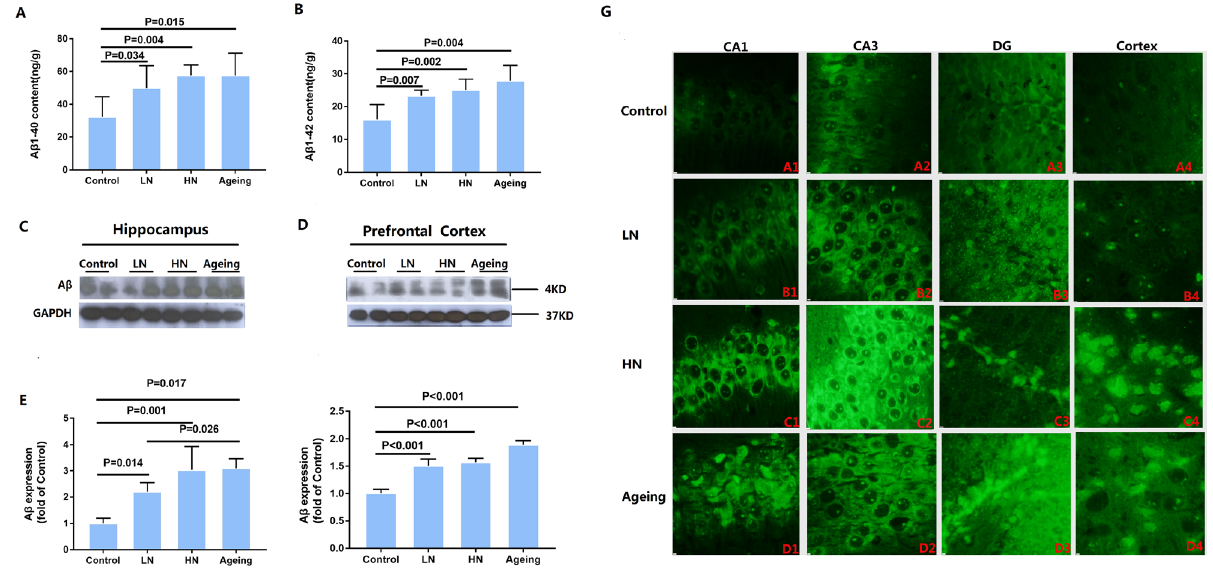
Figure 1. Chronic noise-induced changes of Aβ in SAMP8 mice. Quantification of Aβ 1–40 and Aβ 1–42 level by ELISA ( A , B ). Western Blot analysis of Aβ expression in the hippocampus ( C ) and PFC ( D ) in SAMP8 mice. Quantification of immunoreactive band density measured in Panels C and D, normalized against GAPDH. Quantification of immunoreactive band density measured in E and F. Data are represented as a percent change relative to the control (n = 6 per group). Data are shown as the mean ± standard deviation. HN, high-intensity noise exposure; LN, low-intensity noise exposure. Results were normalized as the control = 100%. The result of the distribution patterns of Aβ by thioflavin T ( G ). Representative images of hippocampal CA1 (A1, B1, C1, D1), CA3 (A2, B2, C2, D2), DG (A3, B3, C3, D3), and PFC (A4, B4, C4, D4) immediately after cessation of noise exposure. Scale bar = 15 μm. CA,Cornu Ammonis; DG, Dentate Gyrus; PFC, prefrontal